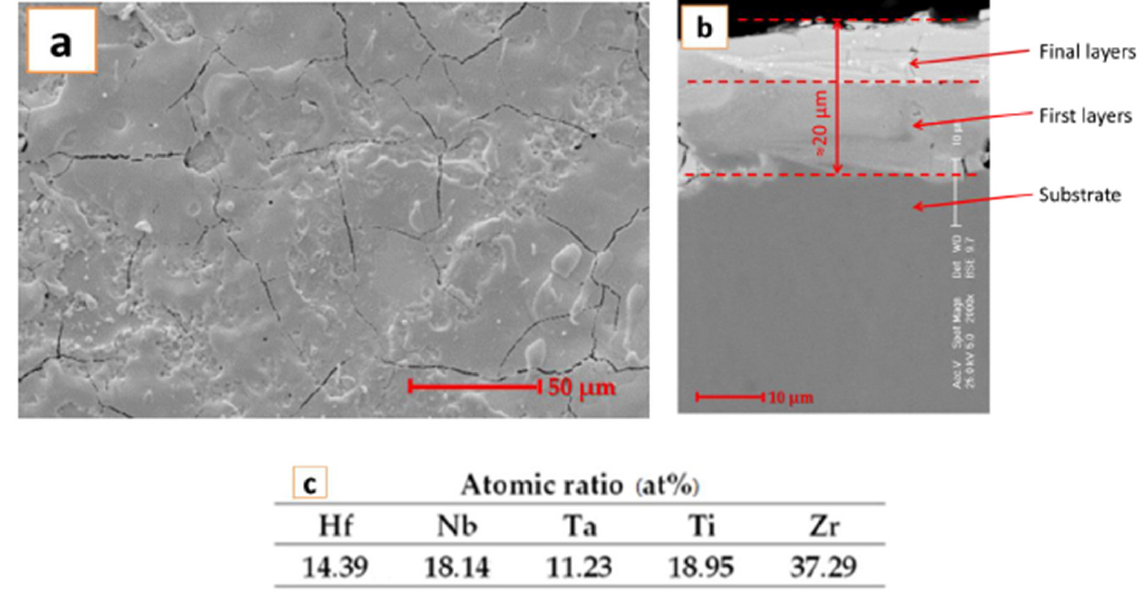
Figure 2. SEM images and EDS analysis results for the HfNbTaTiZr high-entropy alloy coating deposited by the ESD technique for ( a ) top view and ( b ) cross section; ( c ) EDS analyses